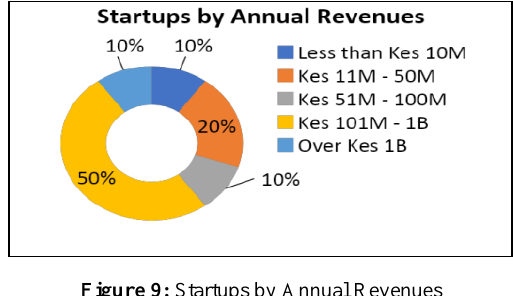
Figure 9: Startups by Annual Revenues